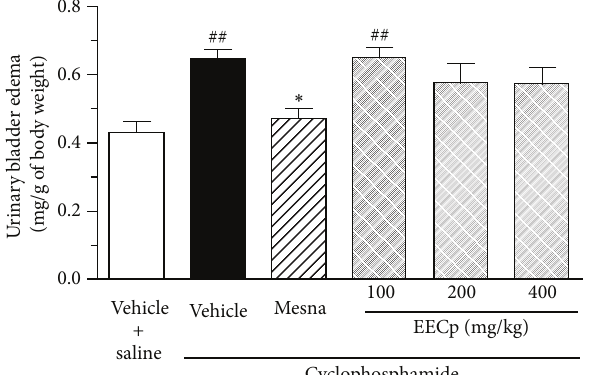
Figure 2: Urinary bladder weight of rats with cyclophosphamide- induced cystitis submitted to treatment with the ethanol extract of Caesalpinia pyramidalis (EECp). Animals were treated with EECp (100–400mg/kg, p.o.), vehicle, or mesna (40 mg/kg, i.p.) and injected with cyclophosphamide (200mg/kg, i.p.). After 24 h, the urinary bladder weight was measured and expressed as mg/g of whole body weight of animals. ## 𝑃 < 0.01 versus vehicle + saline; ∗ 𝑃 < 0.05 versus vehicle +